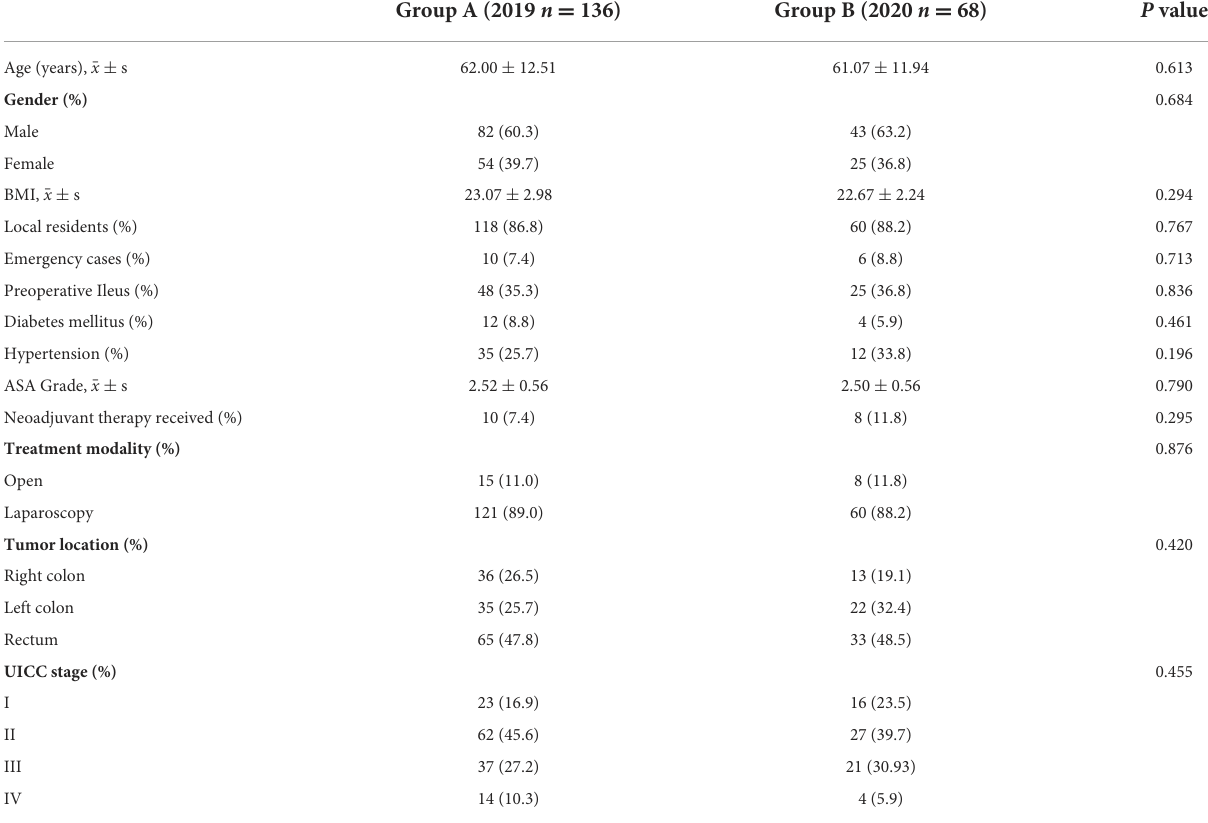
TABLE 1 Basic characteristics of patients.